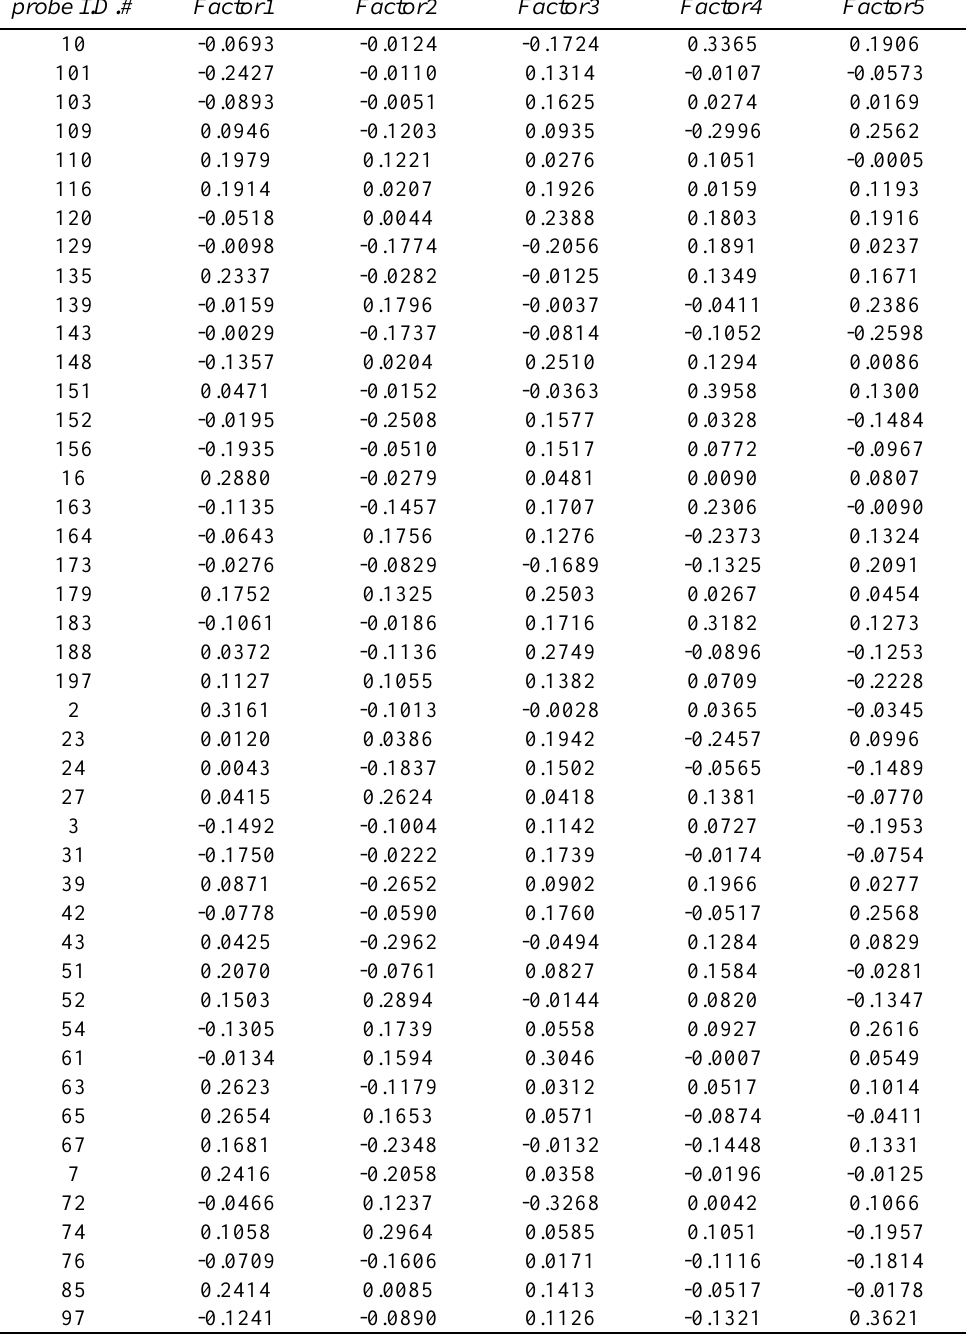
Table 2: The 5-factor oligonucleotide microarray SIM classification model for bovine-origin